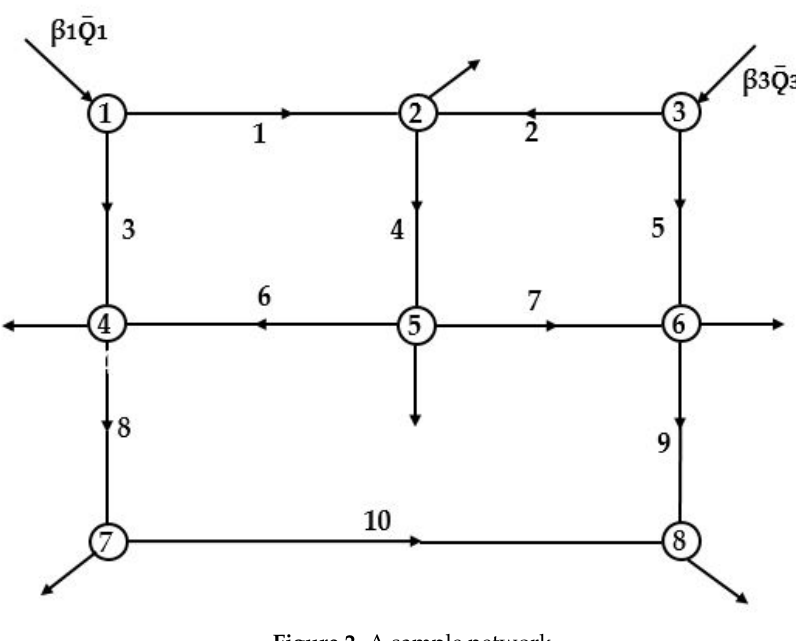
Figure 2. A sample